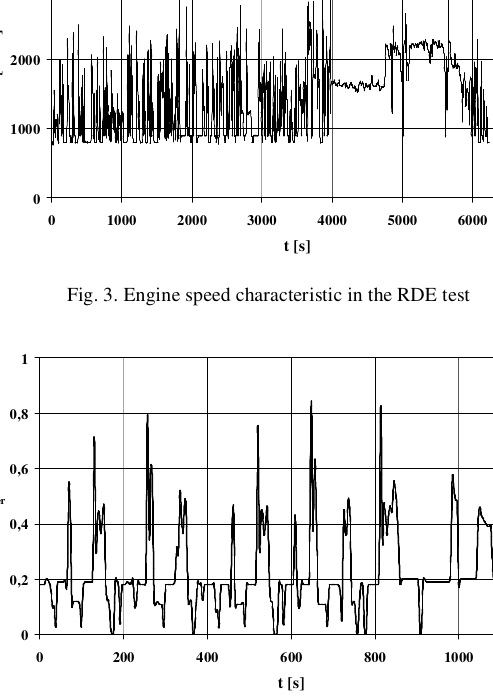
Fig. 4. The relative torque characteristic in the NEDC test